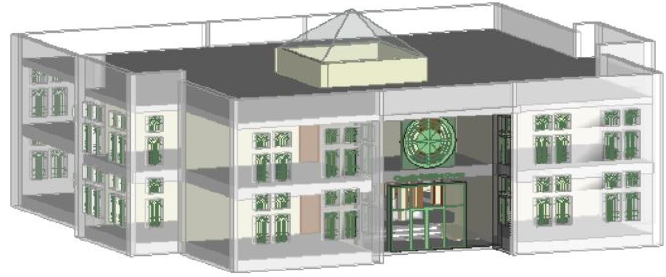
Figure 5. The CBC 3D model.